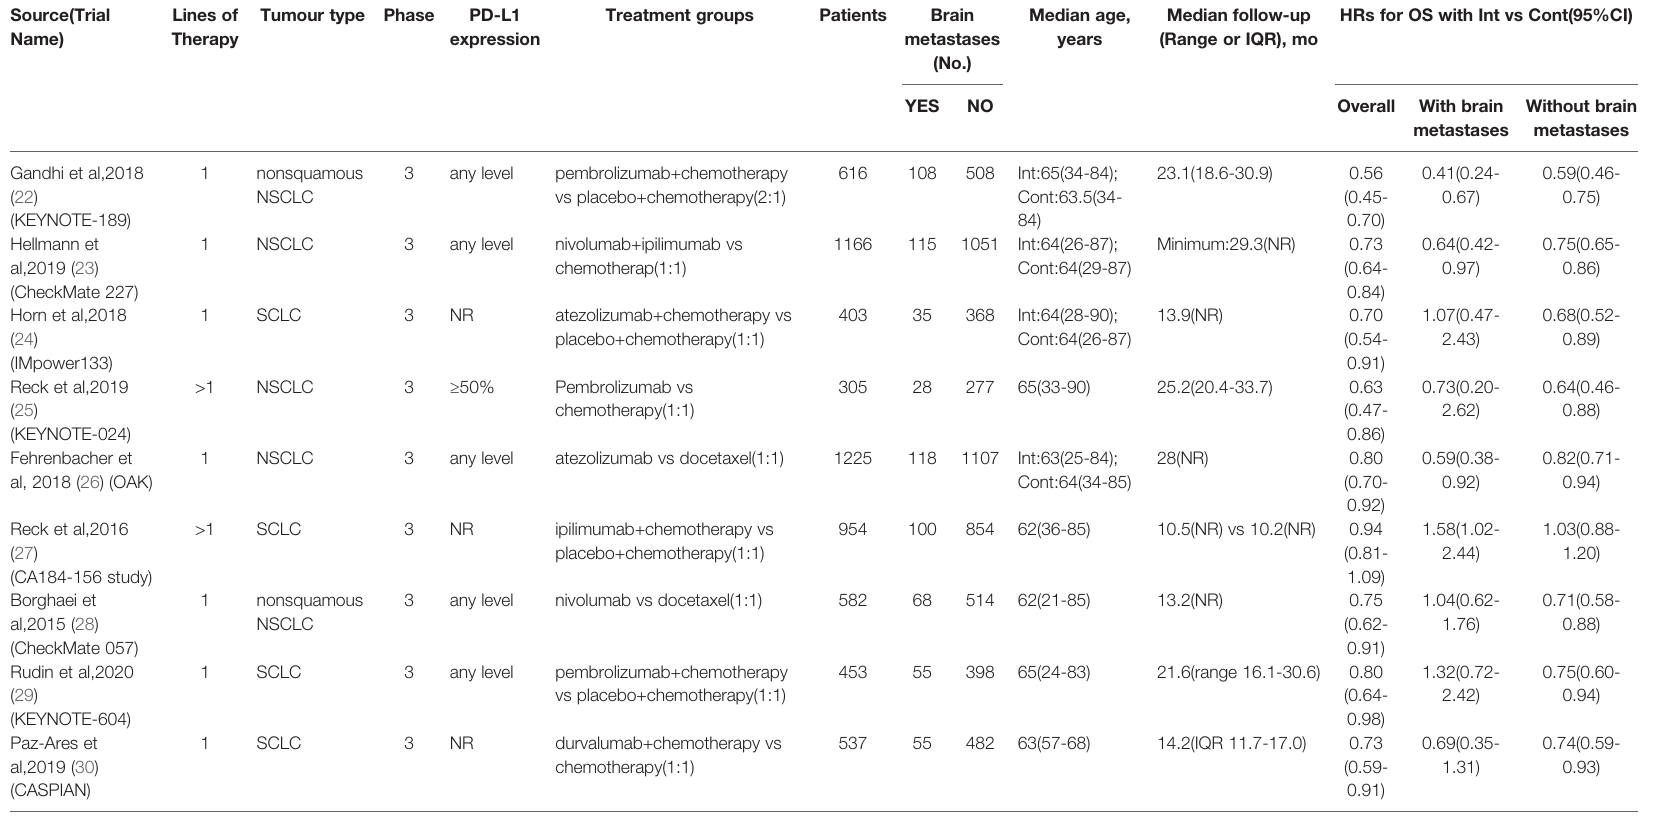
TABLE 1 | Characteristics and outcomes of the 9 trials included in the